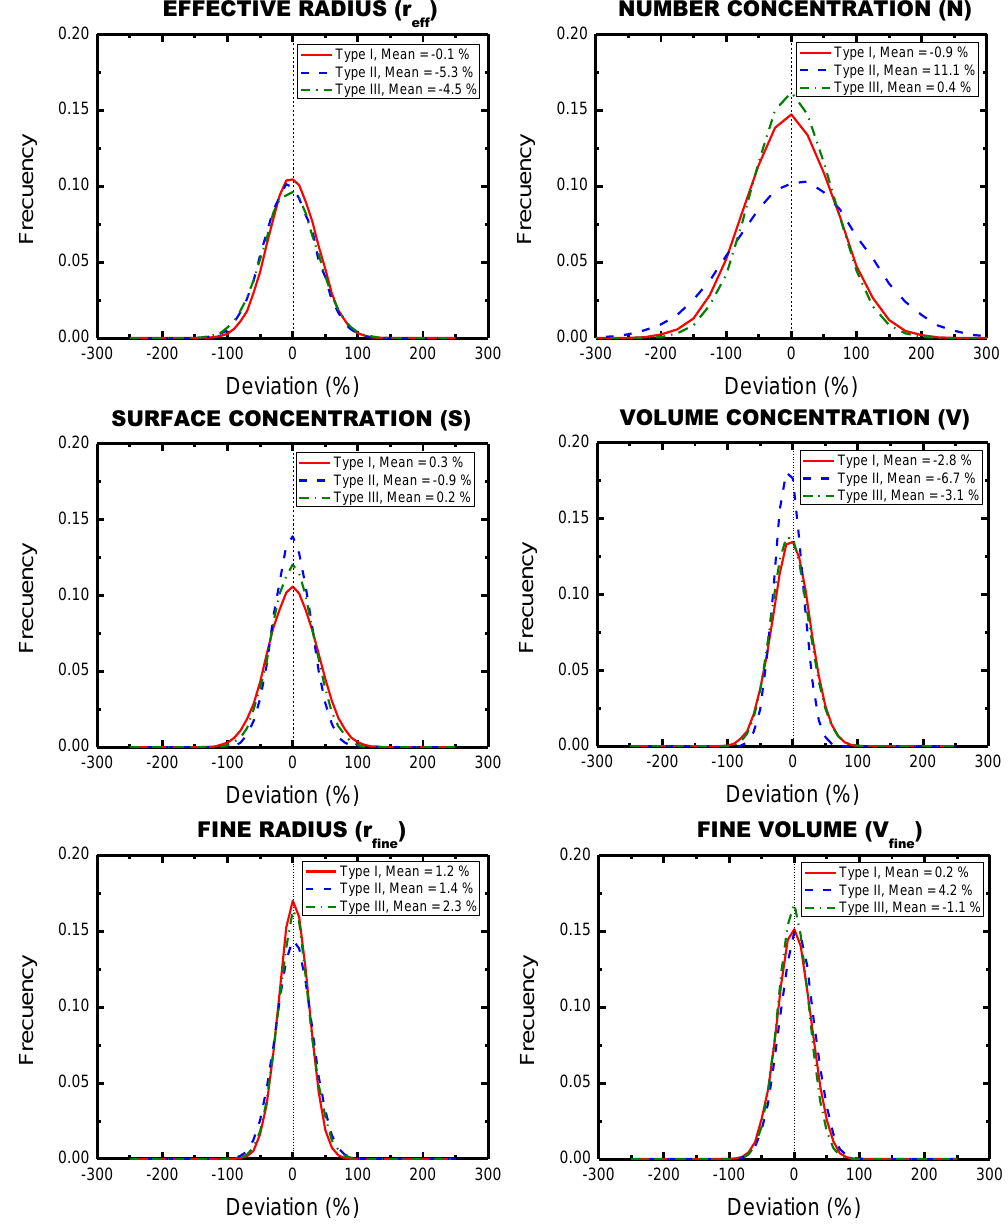
Figure 5: Frequency distributions of the different microphysical parameters for 15% random errors in the optical data using 50000 random samplings of the systematic error sensitivities shown in Table 1. The x axis represents the difference between microphysical parameters with no errors in the input optical data and those affected by random errors in the optical data. Random errors were simulated by a normal distribution centered at zero and with a standard deviation of 15%. The random number generator is initialized at different values for each of the 5 optical data used in the 3 β + 2 α lidar configuration. The mean value of the deviation between the microphysical parameter affected by random error and that unaffected by random error is included in the legend.